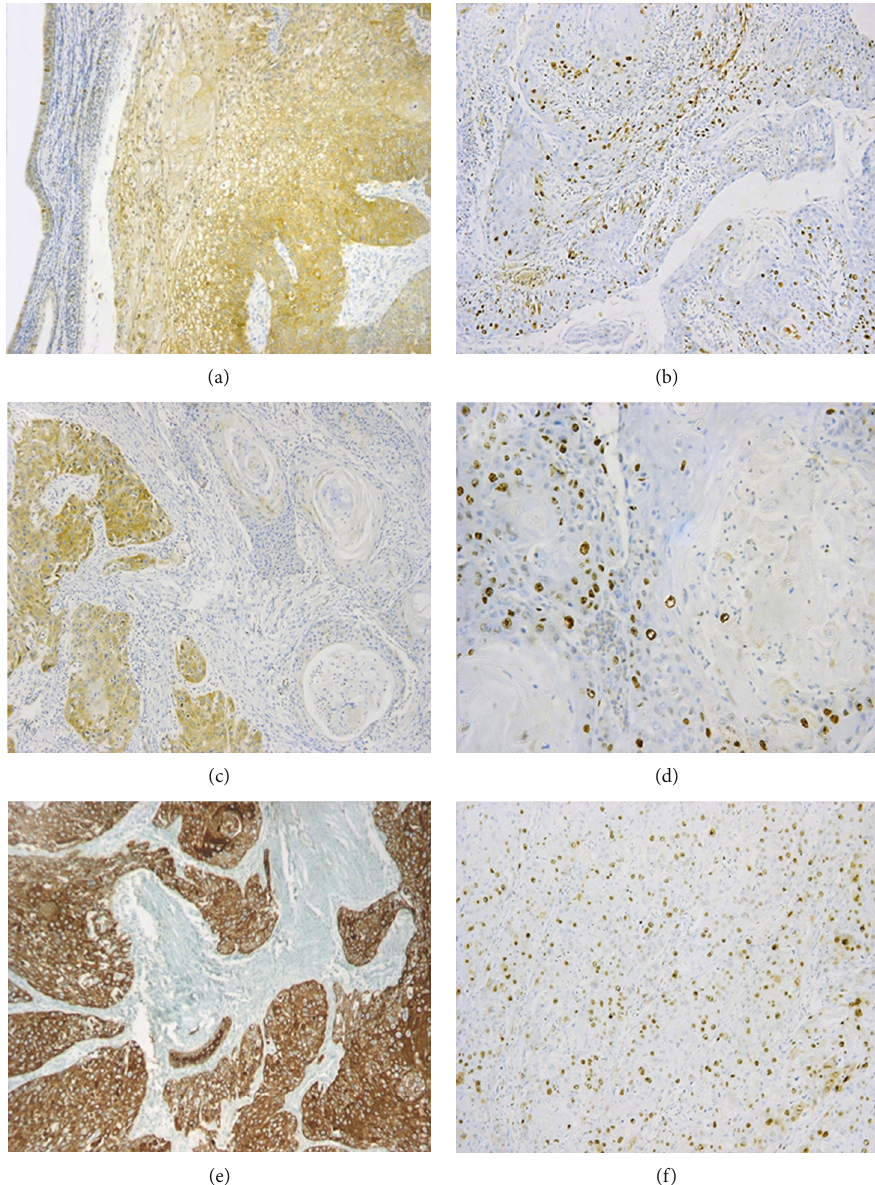
Figure 3: Di ff erent cases of IP-associated sinonasal SCC: (a, c, e) IMP3 IHC cytoplasmic expression in tumor cells (IHC × 100); (b, d, f) Ki-67 IHC nuclear expression in tumor cells ((b, f) IHC × 100, (d) IHC ×